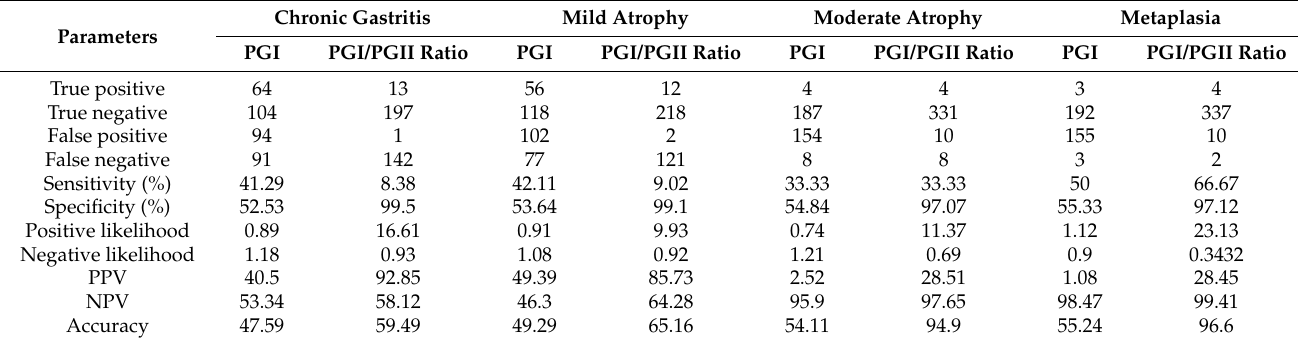
Table 4. Diagnostic value of the Miki criteria to predict gastric mucosa status.